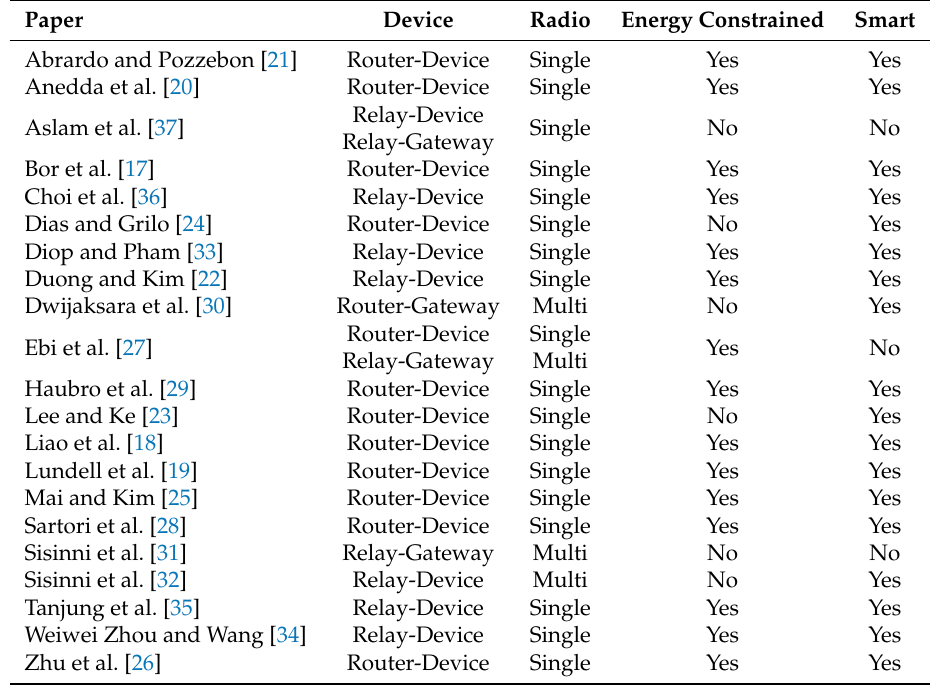
Table 4. Intermediate device functions and